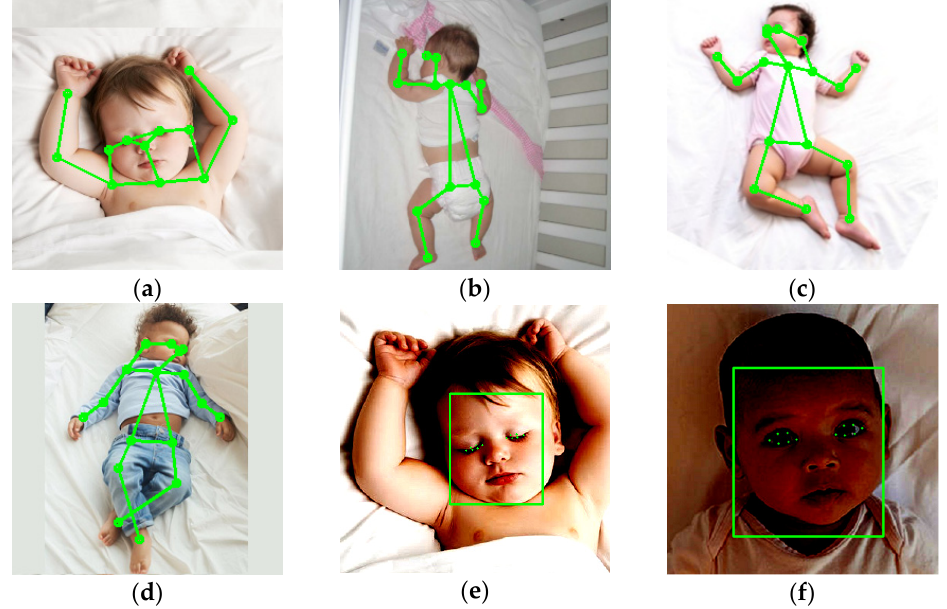
Figure 15. Detection methods applied on real baby images: ( a ) baby sleeping on the back with the blanket on—no alert; ( b ) baby sleeping on stomach causing nose undetected—face covered alert. Hip, knee, and ankle are visible—blanket removed alert; ( c , d ) baby sleeping on the back and nose is visible. Hip, knee, and ankle are visible—blanket removed alert; ( e ) baby sleeping, showing eye landmarks (EAR = 0.19); ( f ) baby awake, showing eye landmarks (EAR = 0.35)—baby awake alert.